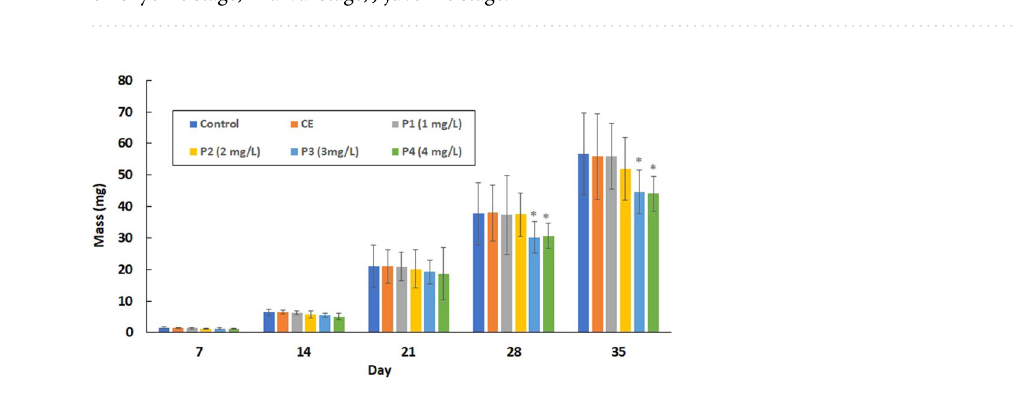
Figure 2. Mean weight of common carp ( Cyprinus carpio ) embryo, larvae and juveniles after praziquantel exposure. SD = standard deviation. *Significantly ( P < 0.01) difference between experimental and control groups. Groups: CE (solvent control, contained 0.8 ml/L ethanol), P1 (praziquantel 1.0 mg/L), P2 (praziquantel 2.0 mg/L), P3 (praziquantel 3.0 mg/L) and P4 (praziquantel 4.0 mg/L).